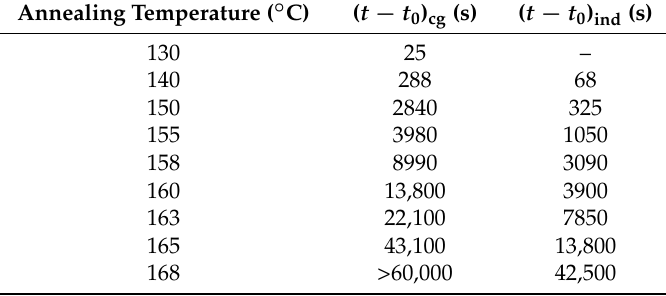
Table 2. The critical gelation and the induction reduced times at different annealing